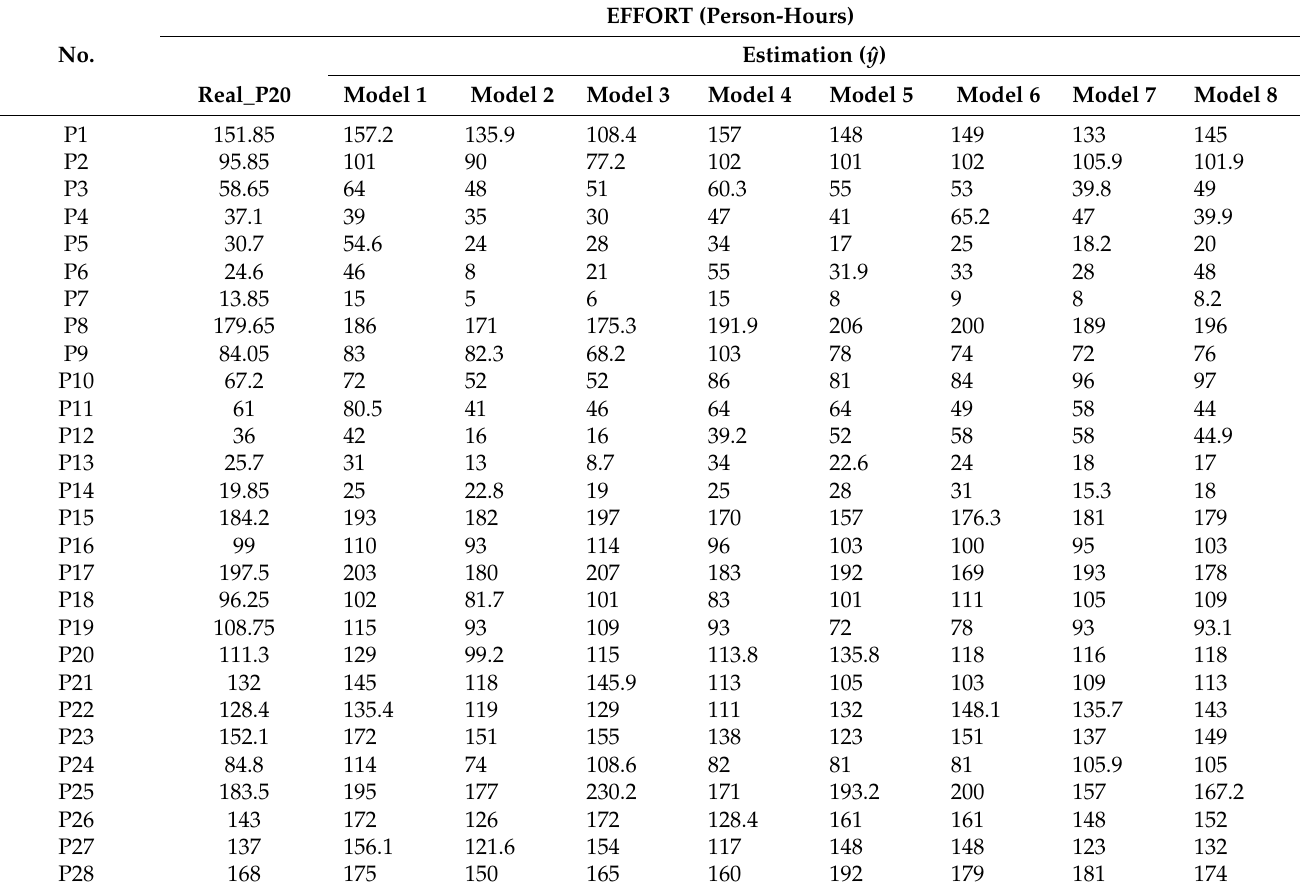
Table 2. The twenty-eight projects and eight different predicted